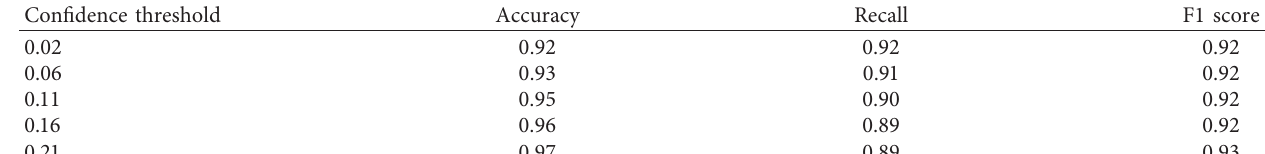
Table 2: Performance of fusion detection algorithm under low confidence threshold.